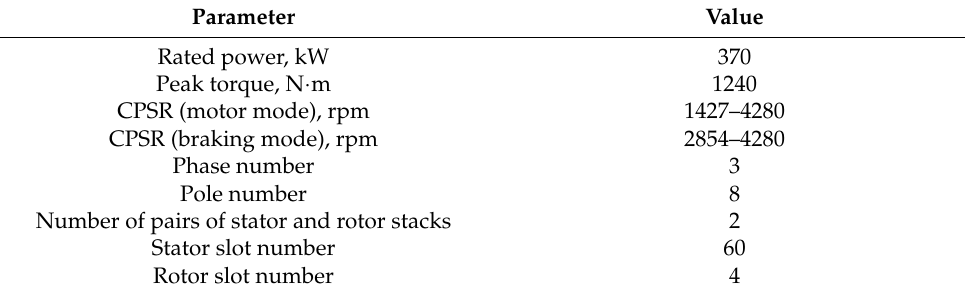
Figure 1. SHM feature representation: ( a ) 1/4 cross-section and stator armature winding layout; ( b ) 3D cutout view. A 1/2 stator cutout is shown. The rotor is shown without cutout. The stator winding is not shown to avoid cluttering up the figure. Table 1. Technical specifications of the SHM.